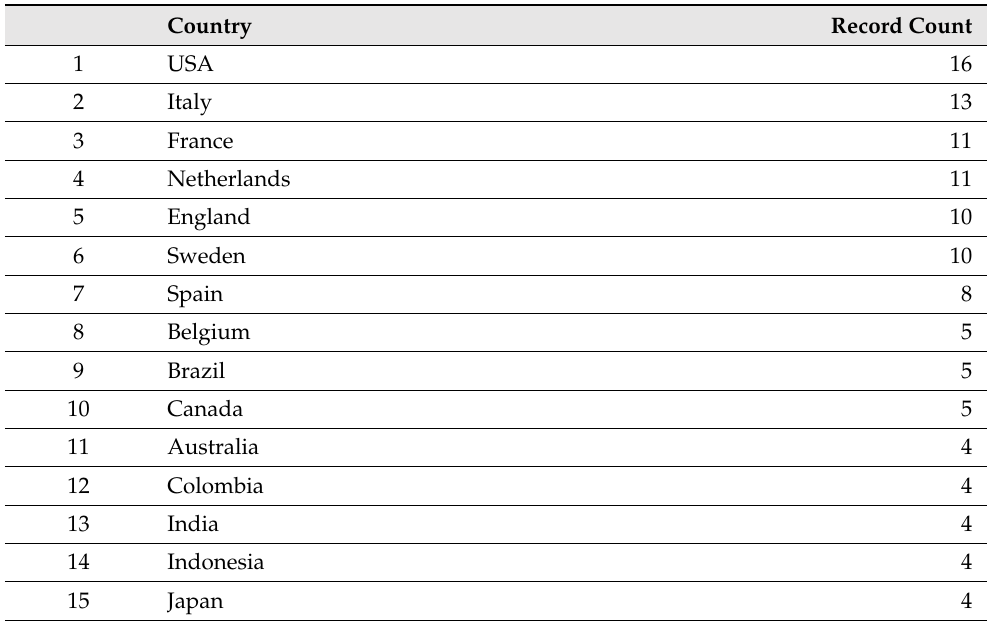
Table 4. Top-publishing countries out of